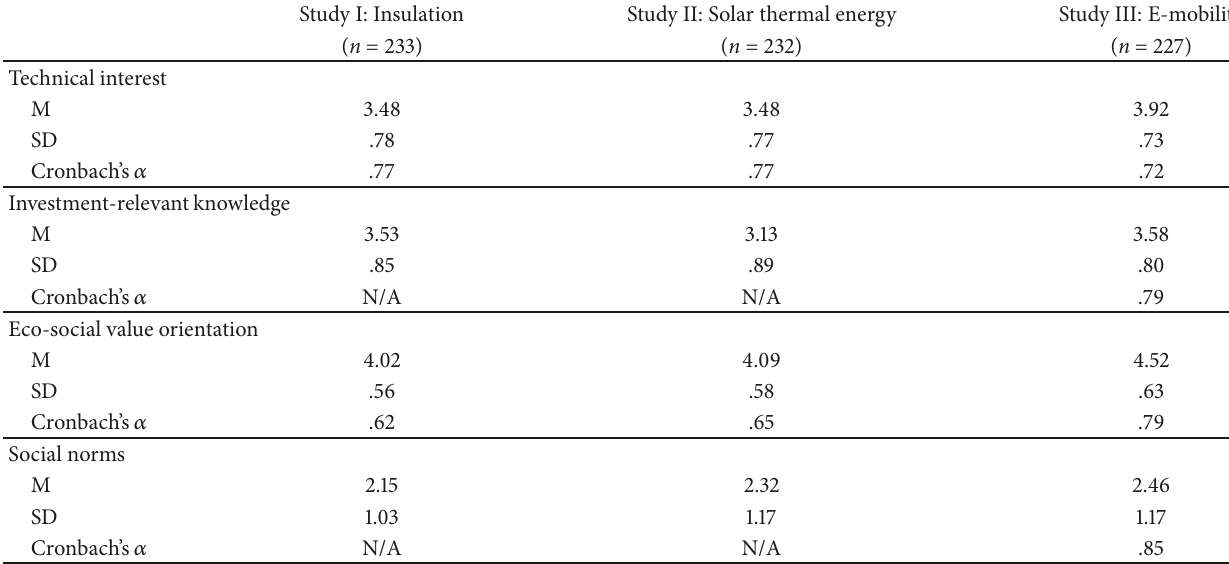
Figure 5: Descriptive data (means and standard deviations) of the independent variables and scales measured within the studies. Most items were measured on a 6-point Likert scale. In studies I and II, investment-relevantknowledge was measured on a 5-point Likert scale. The items were standardized for further analyses. Table 2: Overview of independent